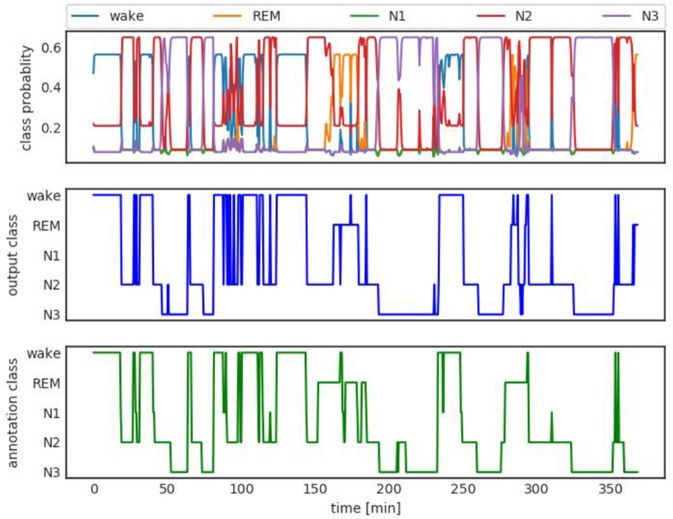
Top: Class probability output. Middle: Hard class decision. Bottom: Ground truth manual staging hypnogram. The hard decision and ground truth agree with Kappa (Cohen, 1960) 0.73.